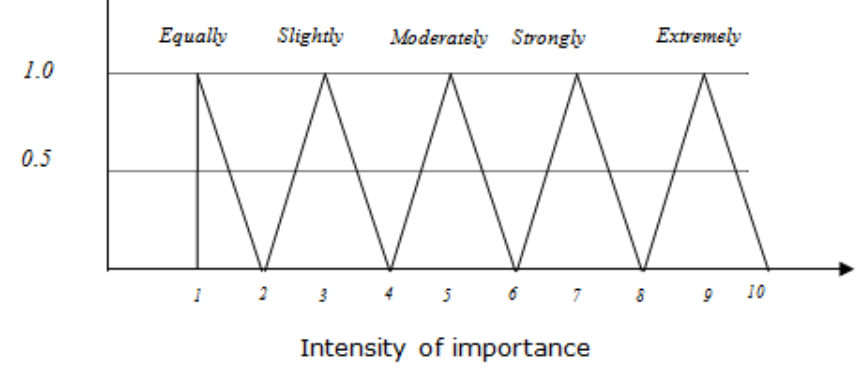
Figure 1. Fuzzy membership function for linguistic